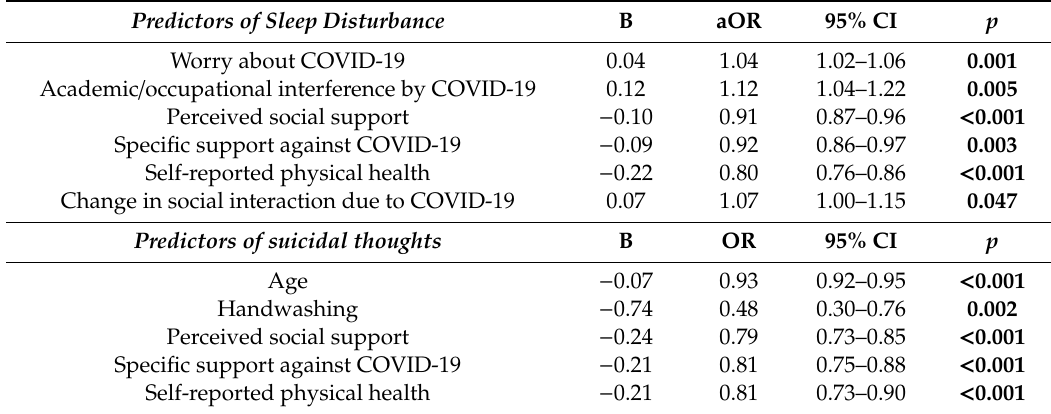
Table 4. Predictors of sleep disturbance and suicidal thoughts examined using forward stepwise logistical